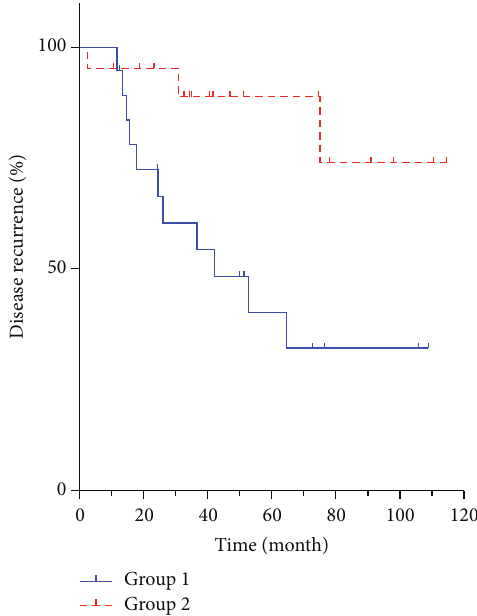
Figure 1: Kaplan-Meier curve for disease recurrence needing fur- ther surgical intervention. Significantly fewer patients who had resections (Group 2) required further intervention (𝑃 = 0.008)